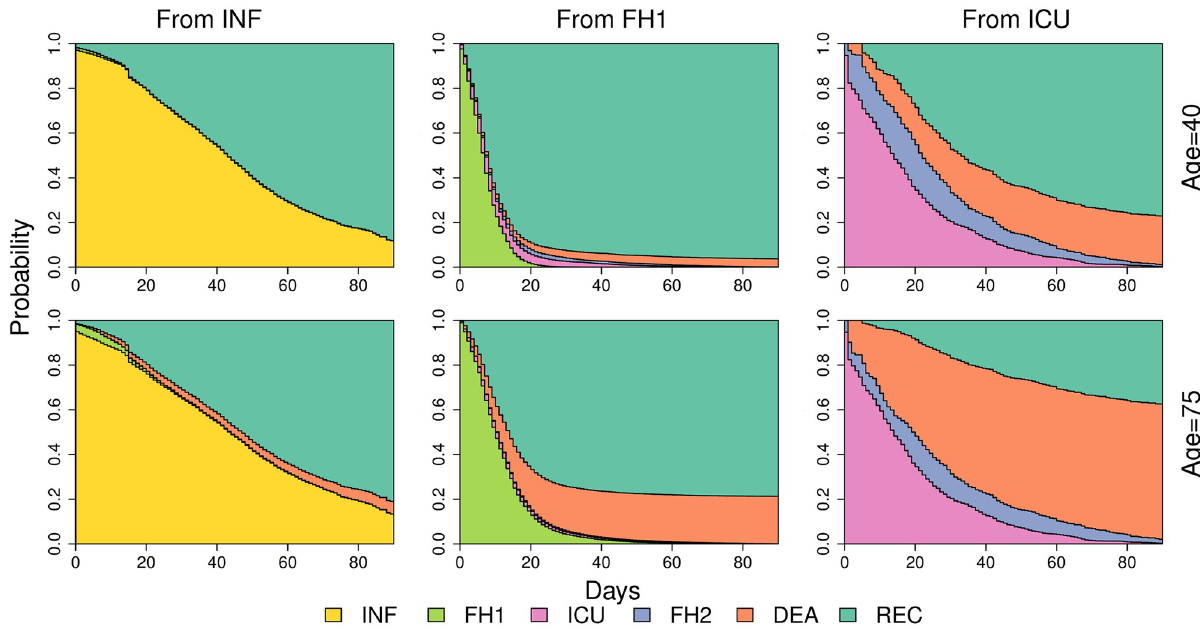
Fig 3. Transition probabilities for two typical patients of ages 40 and 75. The left panel shows transitions from INF to all the other states, the middle panel transitions from hospitalisation and the right panel shows transitions from